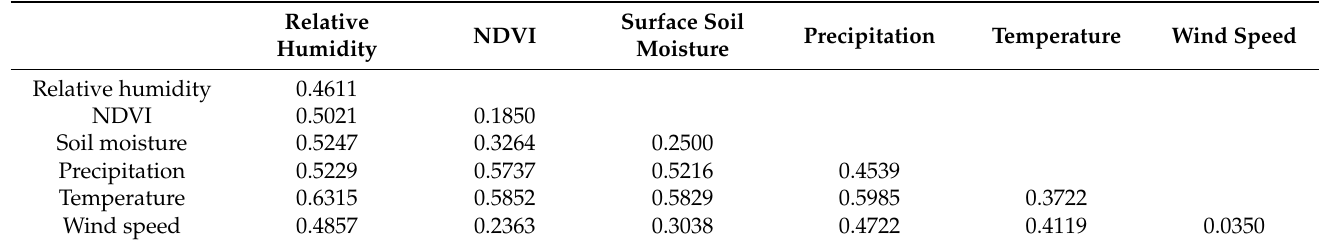
Table 2. Results of the two-factor interaction analysis: influence of two environmental factors together on